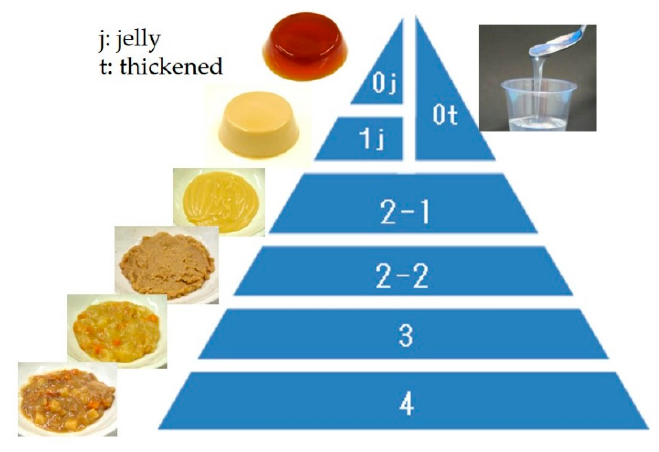
Figure 10. Schema of JDD2013. Table 6. The Texture Profile Analysis (adhesiveness, cohesiveness and hardness) of the Dysphagia Diet Pyramid and the JDD2013.